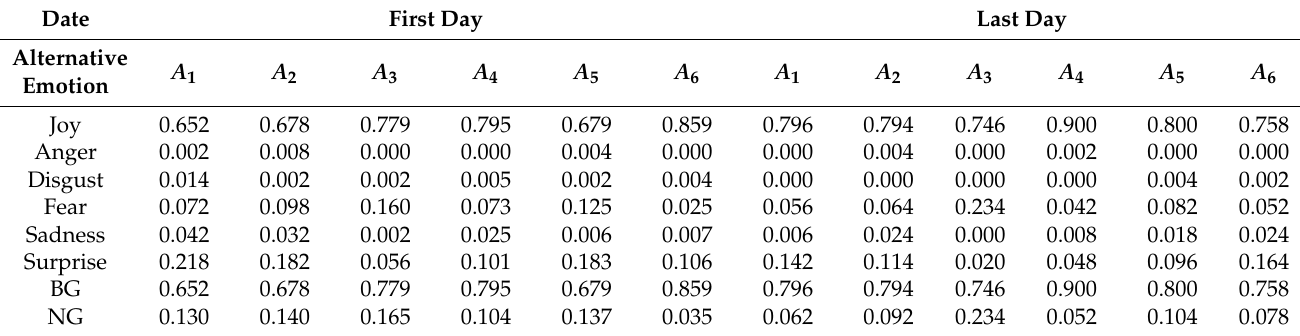
Table 6. Twitter data for COVID-19 vaccines by day and emotion (%).